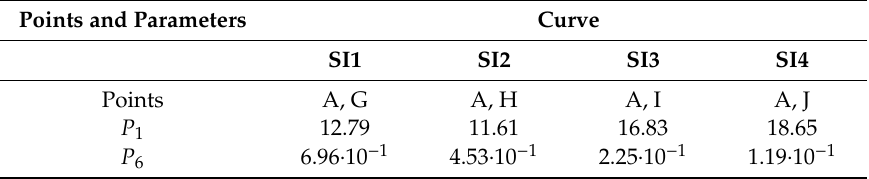
Figure 10. Measured and calculated major hysteresis loop (SML and SMR) and first-order increasing reversal curves (SI1–SI4). 3.3. Calculation of Curves in the Area between the Measured Curves for 9S20